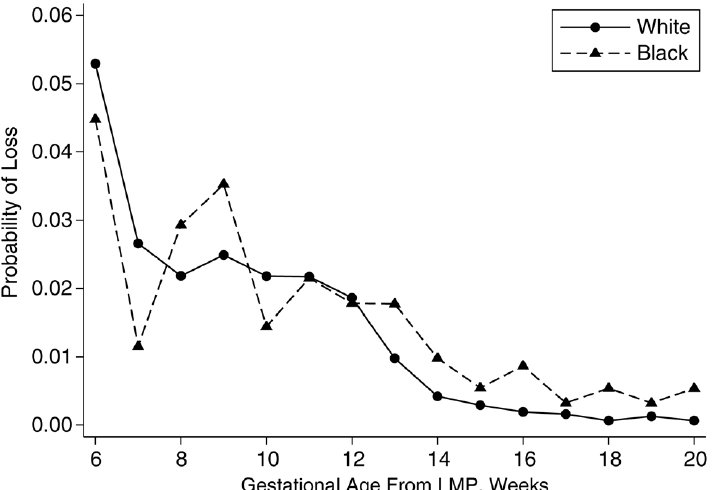
Figure 4. Week-specific probability of pregnancy loss by race among “Right From the Start” participants, 2000–2009. The x -axis is gestational age at loss from last menstrual period (LMP); the y -axis is probability of pregnancies ending in miscarriage